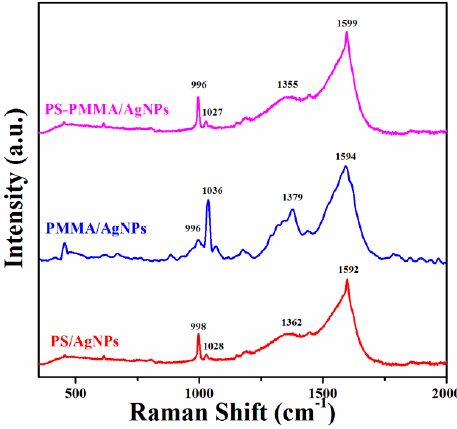
Figure 5. Raman spectra of polymer/AgNPs nanocomposites.